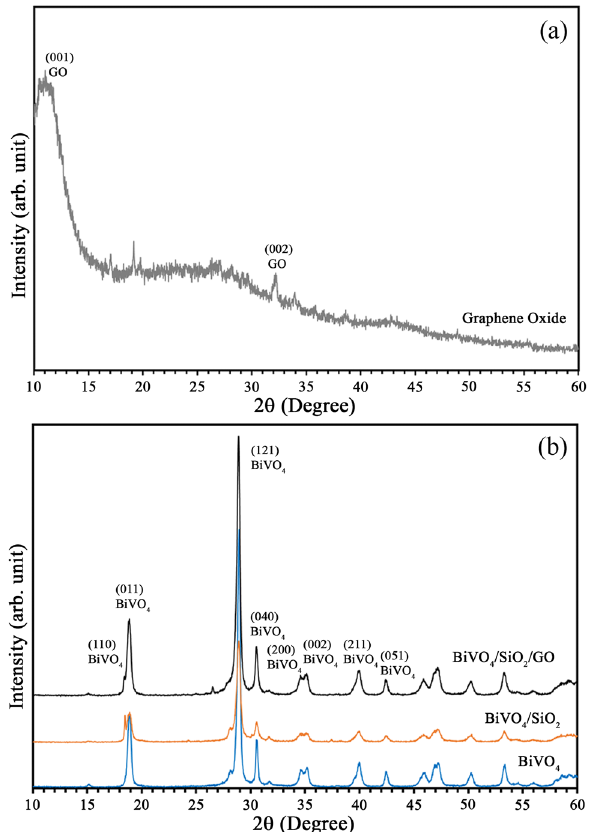
Figure 1. XRD patterns of ( a ) GO nanosheets and ( b ) BiVO 4 , BiVO4/SiO 2 and BiVO 4 /SiO 2